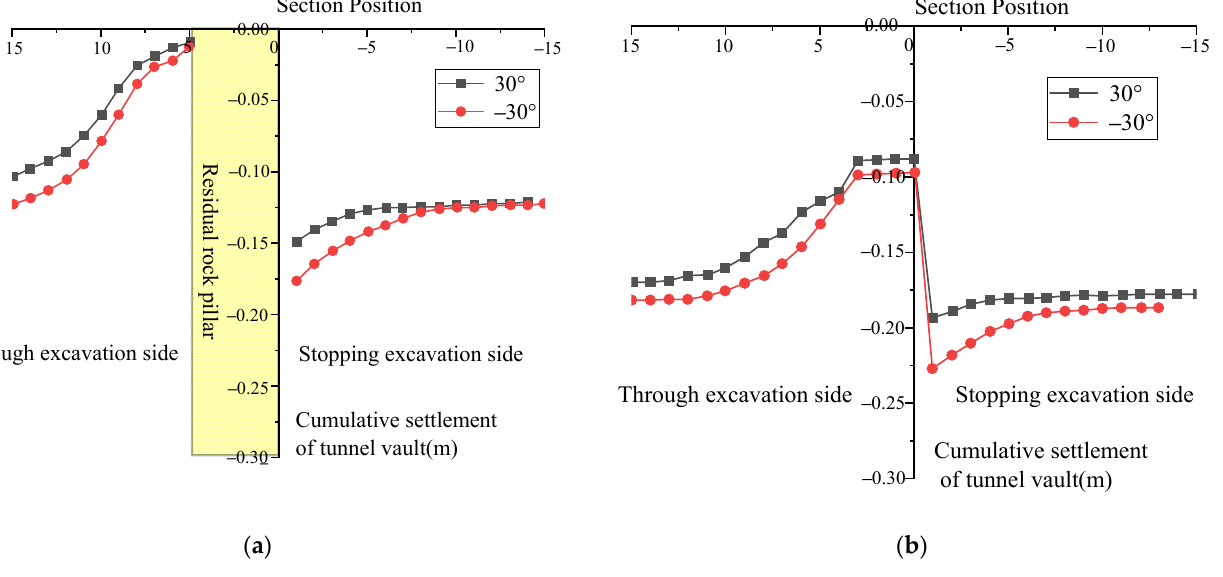
times the tunnel span. 0.5